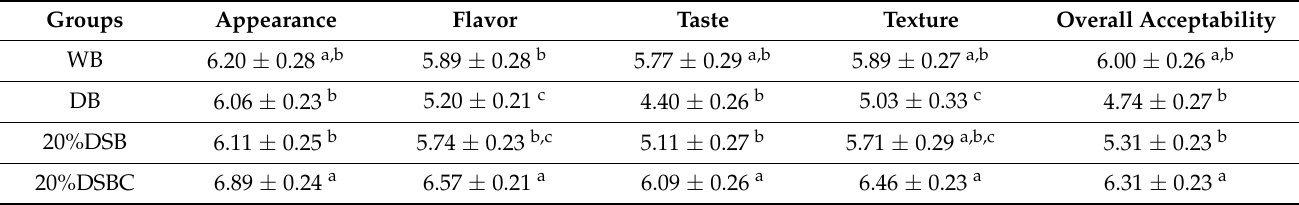
Table 6. Affective analysis of the different bread